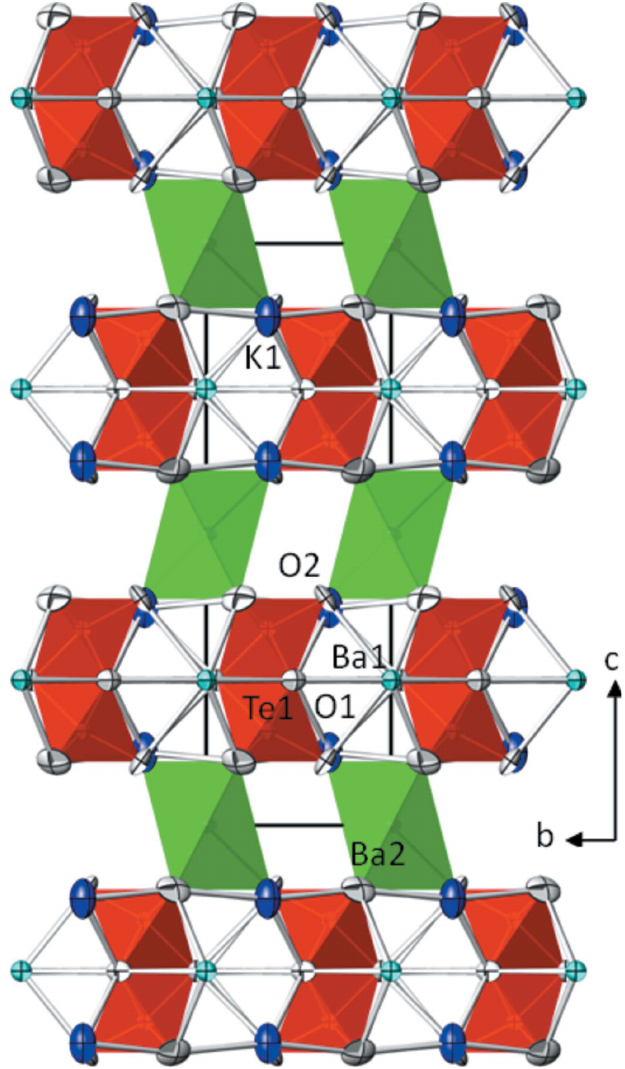
Figure 1 Projection of the crystal structure of Ba 2 K 2 Te 2 O 9 (I) along [100]. [Ba2O 6 ] octahedra are green, [TeO 6 ] octahedra are red, potassium sites are blue, Ba1 sites turquoise and O sites shaded pale grey. Displacement ellipsoids are drawn at the 97% probability